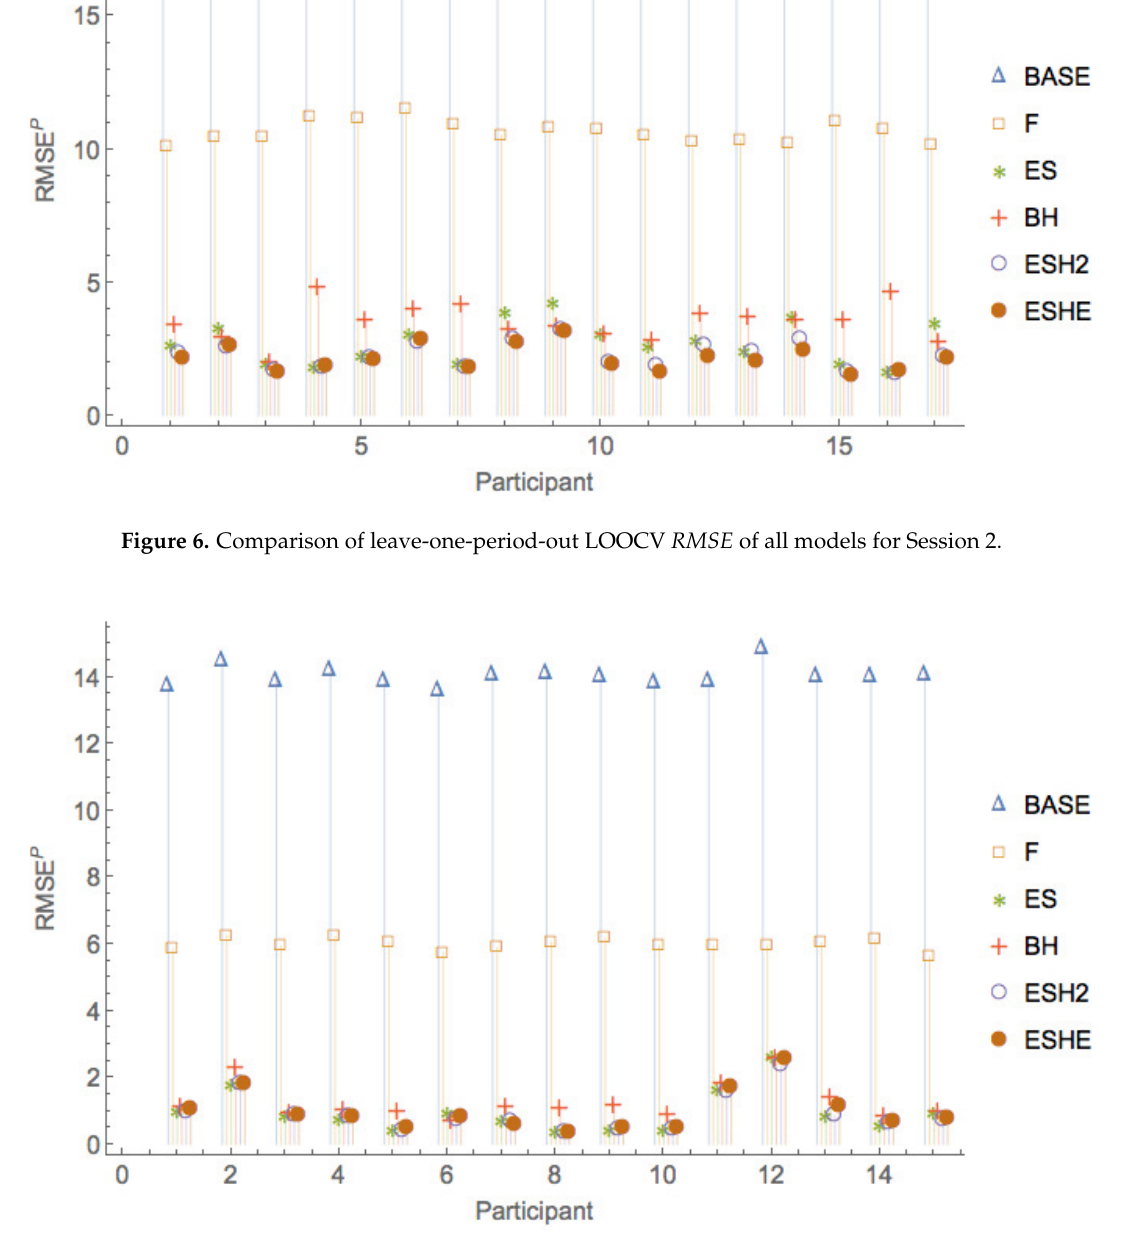
Figure 7. Comparison of leave-one-period-out LOOCV RMSE of all models for Session 3. Figures 8–10 show a comparison of the leave-one-period-out LOOCV RMSE of models ES , BH , ESH 2, ESHE only, that is, leaving out the two worst performing models BASE and F